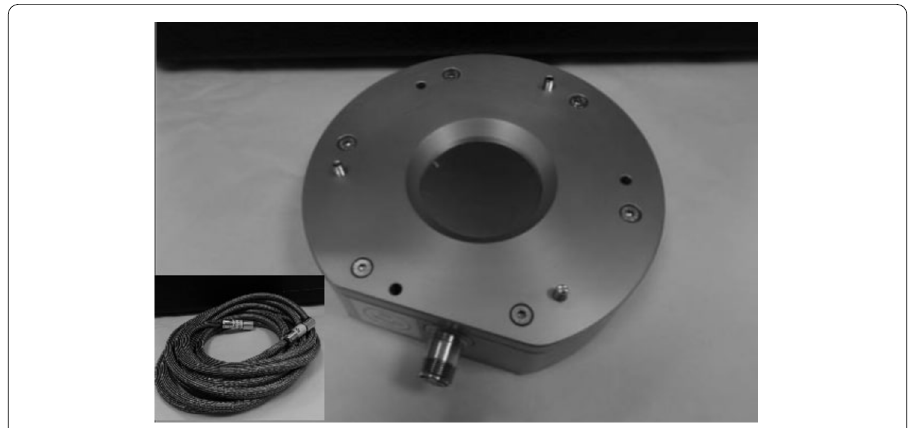
Figure 3 Schematic representation of the I-BM readout concept. The symmetric parallel plate ionisation chamber pair on the left is fed with a biasing voltage on its central electrode. One of the chambers is boron coated. γ -induced signals together with noise are annihilated while the neutron signal is read out by a noise-optimised TIA, limited in bandwidth to about 125 kHz. In the final design the bandwidth is actually limited to 50 kHz, precisely the bandwidth needed to detect a Gaussian pulse of 10 μ s FWHM